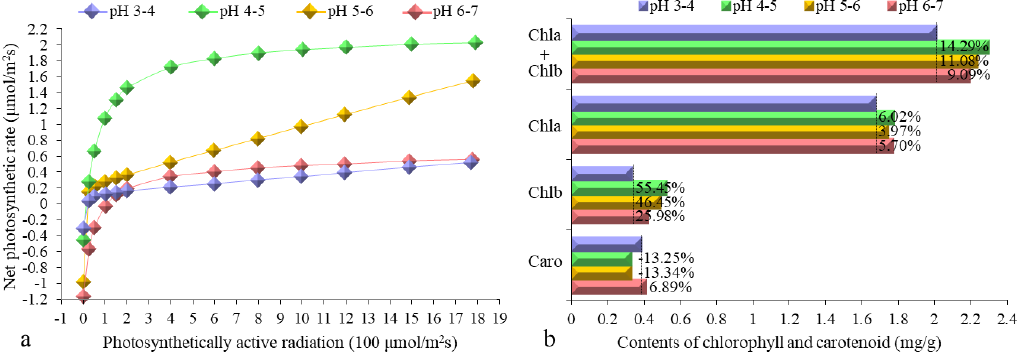
Figure 2. Pn-PAR response curves ( a ) and contents of chlorophyll and carotenoids ( b ) of J. sigillata seedlings subjected to soils with different pH values. The percentage in the top bar in ( b ) shows the percentage increase for each treatment compared with the pH 3 – 4 treatment. The four colors indicate different pH values: pH 3 – 4 (purple), pH 4 – 5 (green), pH 5 – 6 (orange), and pH 6 – 7 (red). Chla — chlorophyll a, Chlb — chlorophyll b, Caro — carotenoid, Pn — net photosynthetic rate, PAR — photosynthetically active radiation.